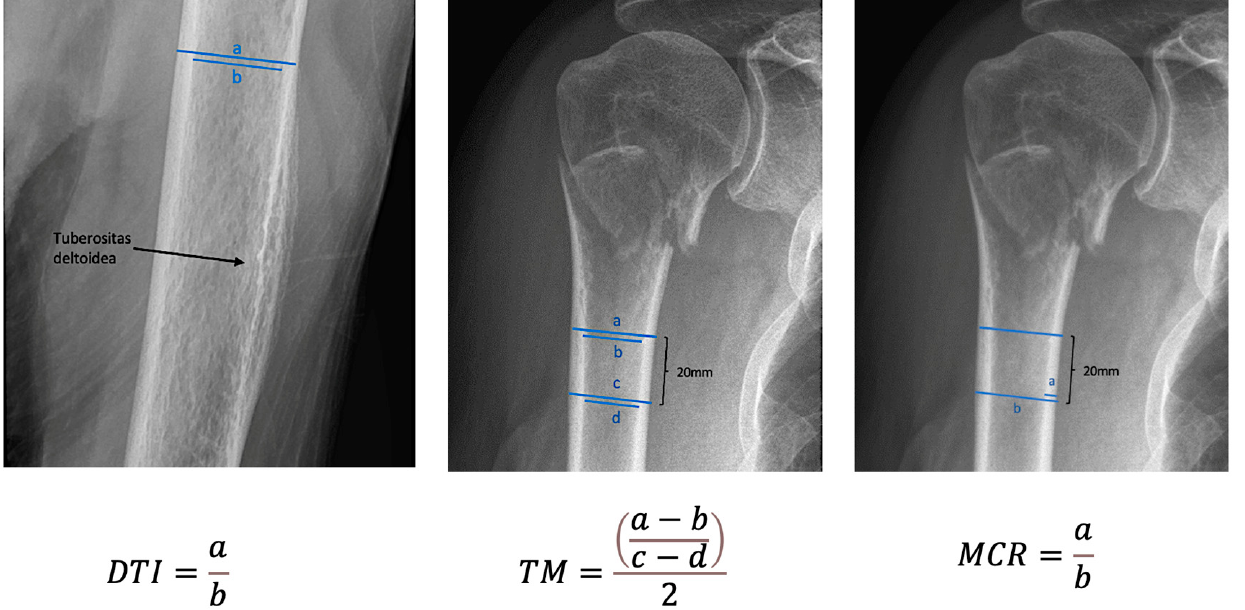
Figure 1. Illustration of the measurement and calculation of the deltoid tuberosity index, Tingart measurement, and the medial cortical ratio.